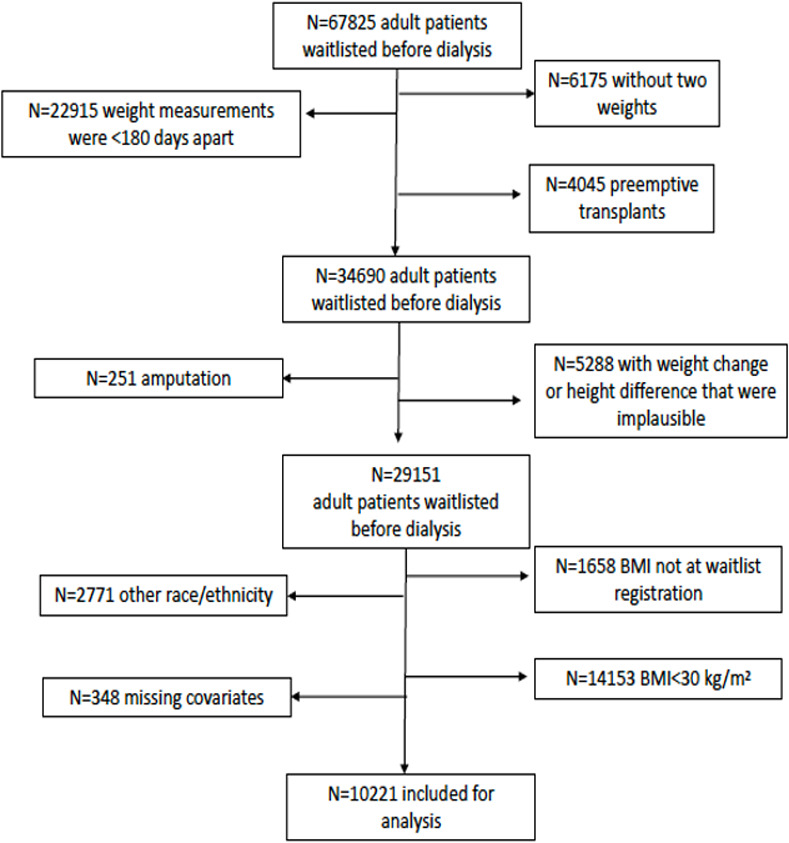
Consort diagram.